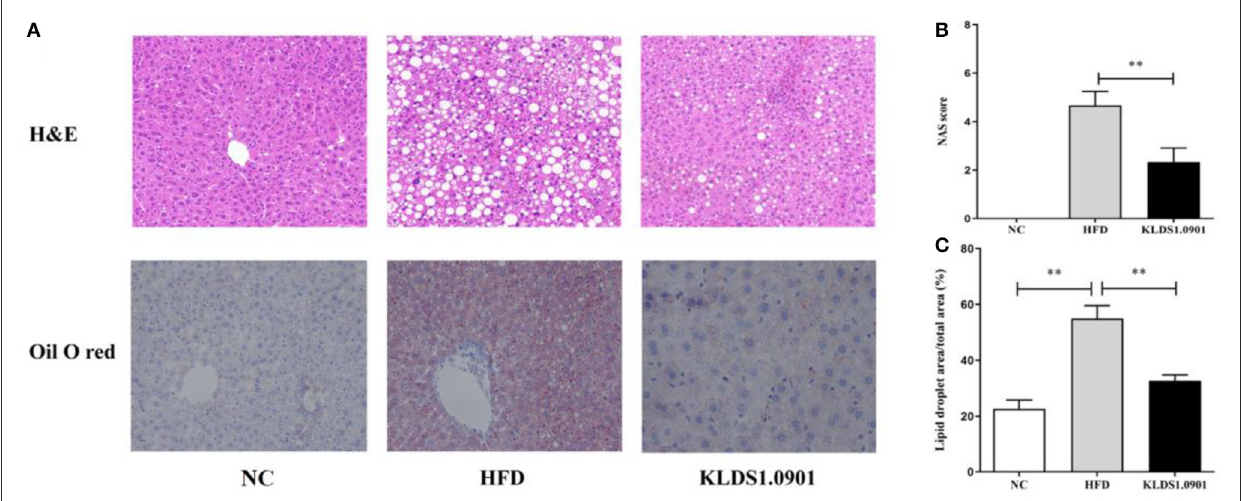
FIGURE4 Effects of L. acidophilus KLDS1.0901 administration on histological alterations of the liver. NC, normal control group; HFD, high-fat diet group; and KLDS1.0901, L. acidophilus KLDS1.0901 group. (A) The representative histological changes of liver sections; (B) NAFLD Activity Score (NAS); and (C) quantification of Oil Red O-stained hepatic lipid droplets. Values are expressed as mean ± SD ( n = 8). ** p < 0.01 indicated that there was a significant difference when compared with the HFD